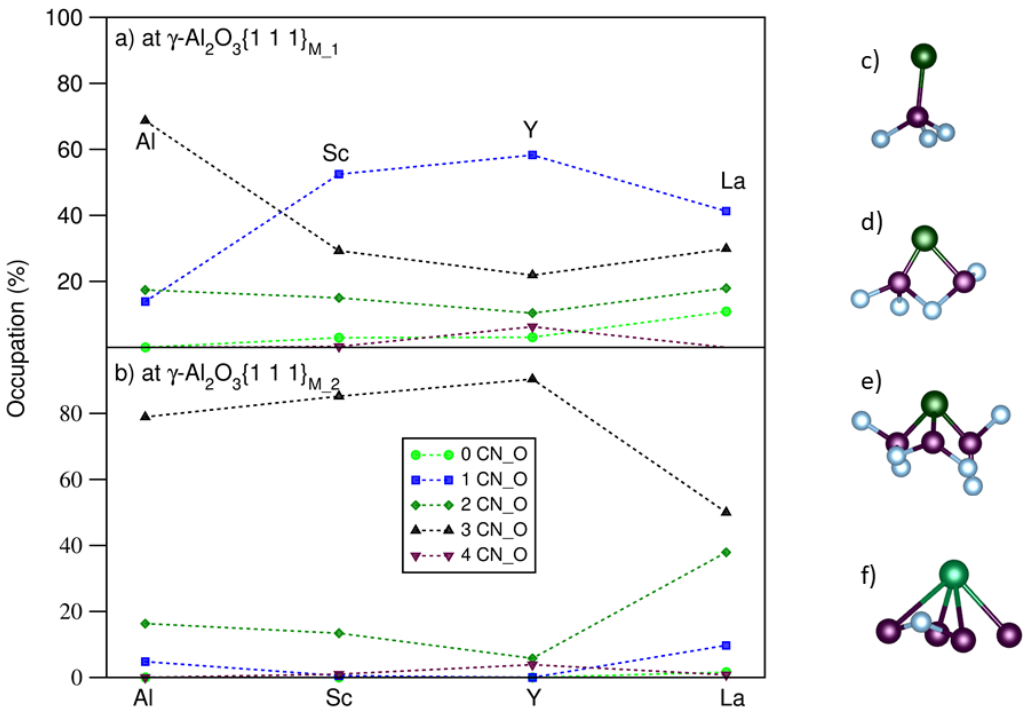
Figure 4. Statistics for the coordination numbers (CN) of Al and M by O at the Al( l )/ γ -Al 2 O 3 {1 1 1} AlM interfaces (left, ( a , b ). The coordination of M by O in right: ( c ) CN = 1, ( d ) CN = 2, ( e ) CN = 3 and ( f ) CN = 4. Clearly, at Al( l )/ γ -Al 2 O 3 {1 1 1} AlM_2 , the M atoms prefer on top of O triangles ( e ), whereas at Al( l )/ γ -Al 2 O 3 {1 1 1} AlM_1 M are positioned dominantly on O ( a ). The statistics confirms our observa-